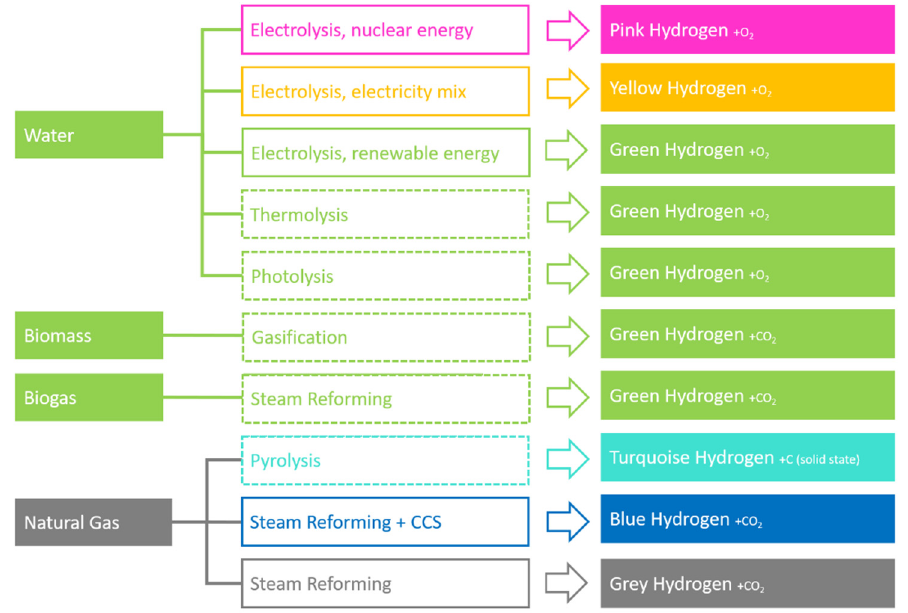
Figure 1. Overview of possible hydrogen production pathways using various technology options and electricity sources. Dashed boxes indicate technologies that are not yet available on an industrial scale.